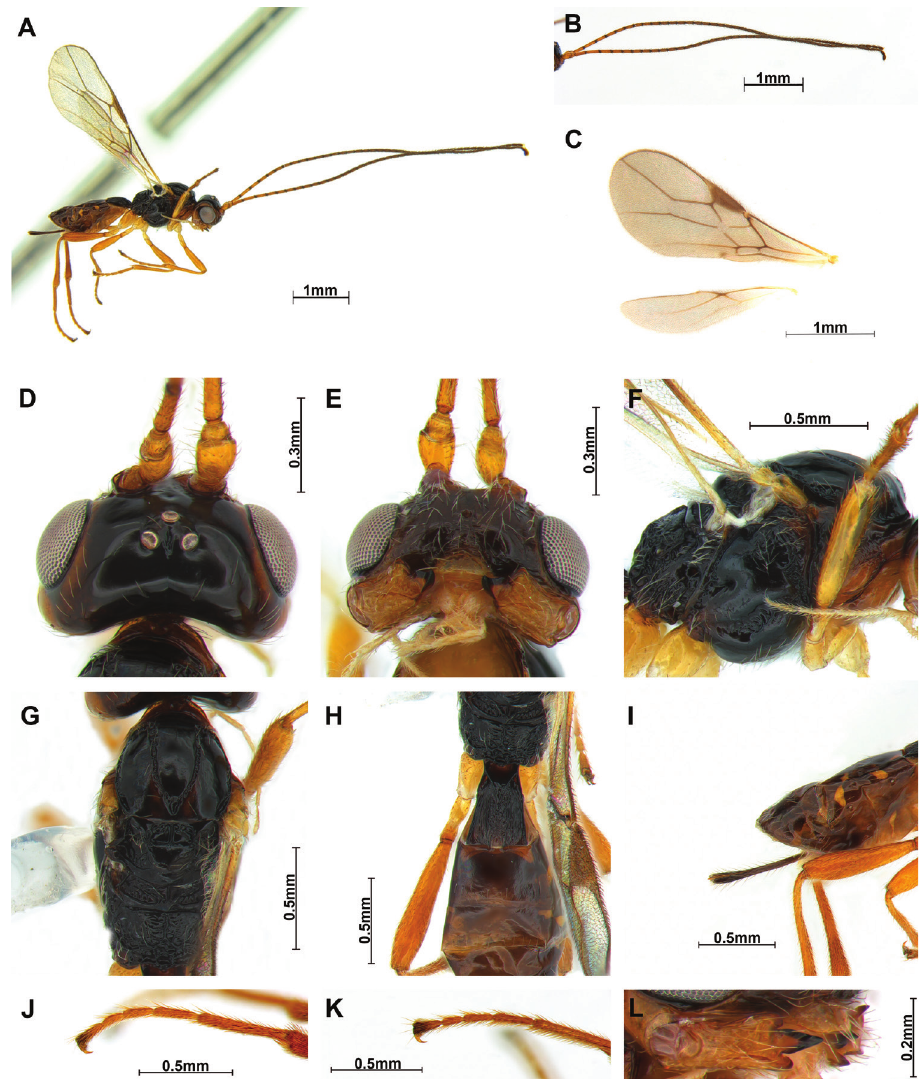
Figure 2. Phaenocarpa brachyura sp. nov., ♀ A body B antennae C wings D head, dorsal E head, anterior F mesosoma, lateral G mesosoma, dorsal H propodeum and T1 to T3, dorsal I ovipositor and its sheaths, lateral J tarsus, lateral K tarsus, dorsal L mandible,